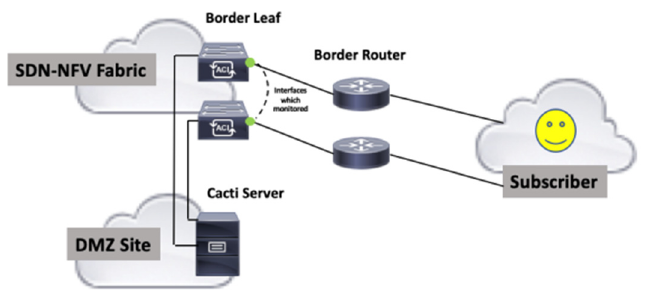
Figure 11. Test topology schematic using Cacti.